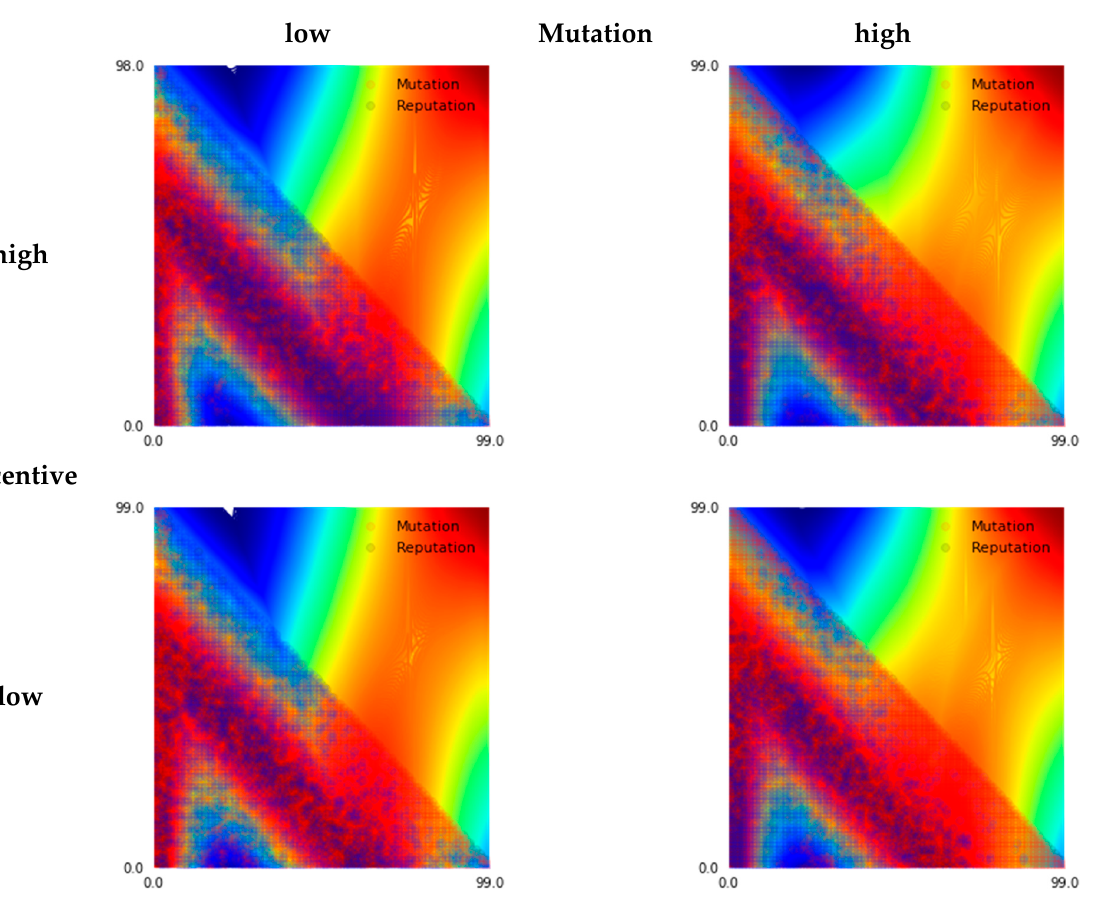
Figure 5. Cultural evolutionary dynamics with replicator–mutator dynamics. The parameters of the upper plots are N = 5, c = 1, g = 0.5, r = 3, and µ = 1 × 10 − 10 ( left ), and µ = 1 × 10 − 1 ( right ). The bottom plots have N = 5, c = 1, g = 0.5, r = 1.8, and µ = 1 × 10 − 10 ( left ), and µ = 1 × 10 − 1 ( right ) (see Tables 6 and 7 for more details regarding the added parameters). The colors indicate prototypes as proportions of the implementation by cooperators (blue), defectors (red), and loners (yellow to green).